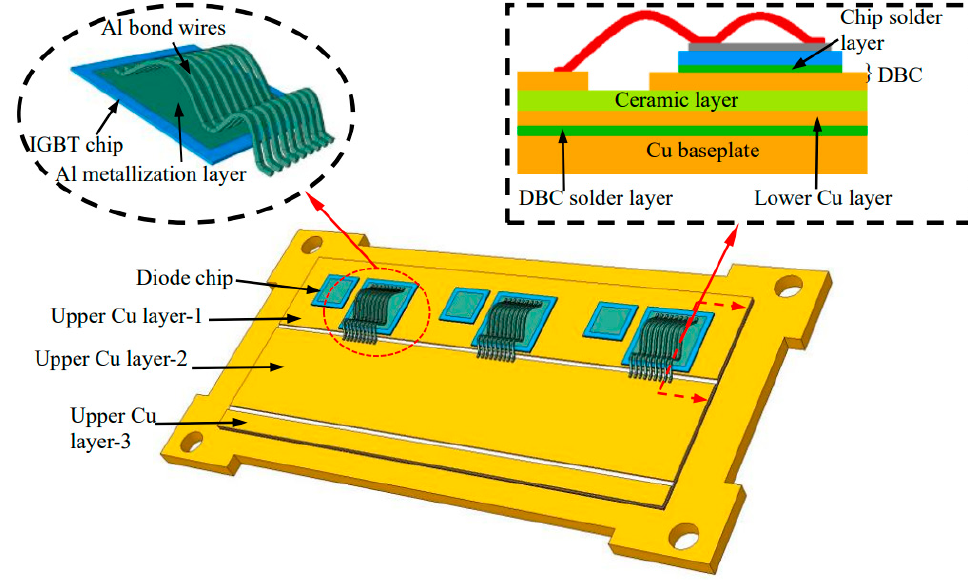
Figure 12. Three-dimensional FE model of the IGBT module.